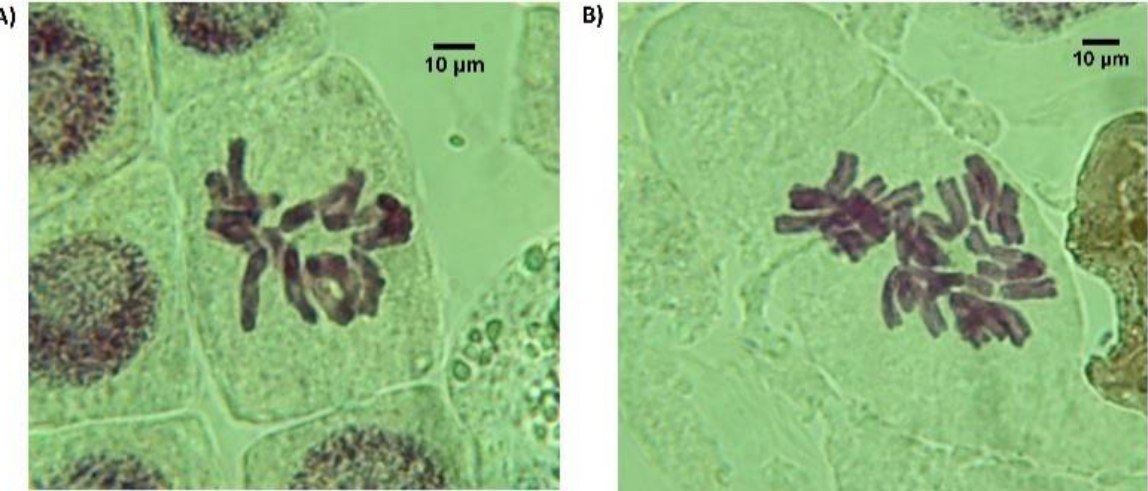
Figure 2. Chromosome counting of C. fragrans . ( A ) Chromosome numbers in diploid C. fragrans (2n = 2x = 12). ( B ) Chromosome number in induced tetraploid C. fragrans (2n = 4x = 24) under 100 × magnification.